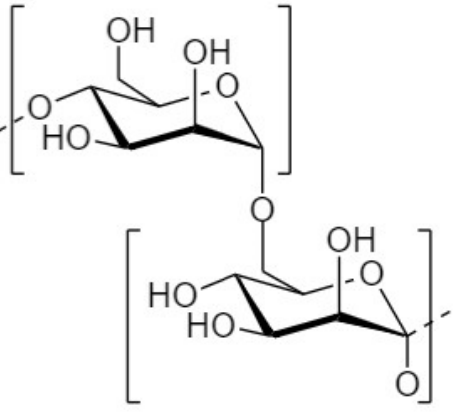
Figure 7. MOS structure: the main components of MOS are 1,4-linked β - D -mannose and 1,4-linked β - D -glucose or 1,6-linked α - D -galactose. MOS, mannan-oligosaccharides.